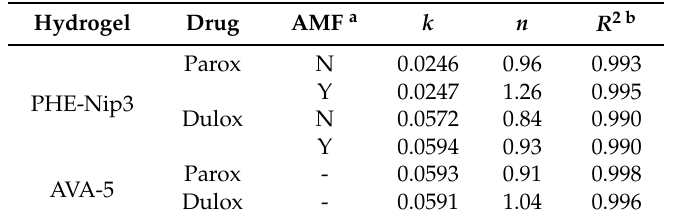
Figure 2. Releasing profiles (% in relation to time) of paroxetine from the hydrogels AVA-5 (blue circles) and PHE-Nip3 without (black squares) and with (red squares) alternating magnetic fields (AMF) stimulation in phosphate buffered saline (PBS) buffer pH 7.40 and 25 °C. Table 2. Parameters of the empirical Peppas’s power law expression ( M t / M ◦ = kt n ) for the release of paroxetine and duloxetine through the hydrogels PHE-Nip3 and AVA-5 in PBS buffer (pH 7.40) with and without AMF